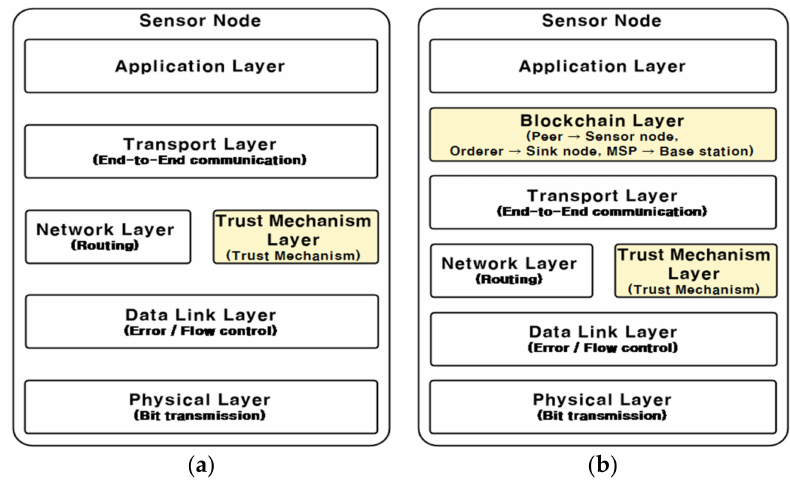
Figure 5. Networking frameworks of existing model and proposed model in a sensor node. ( a ) existing model; ( b ) proposed model.